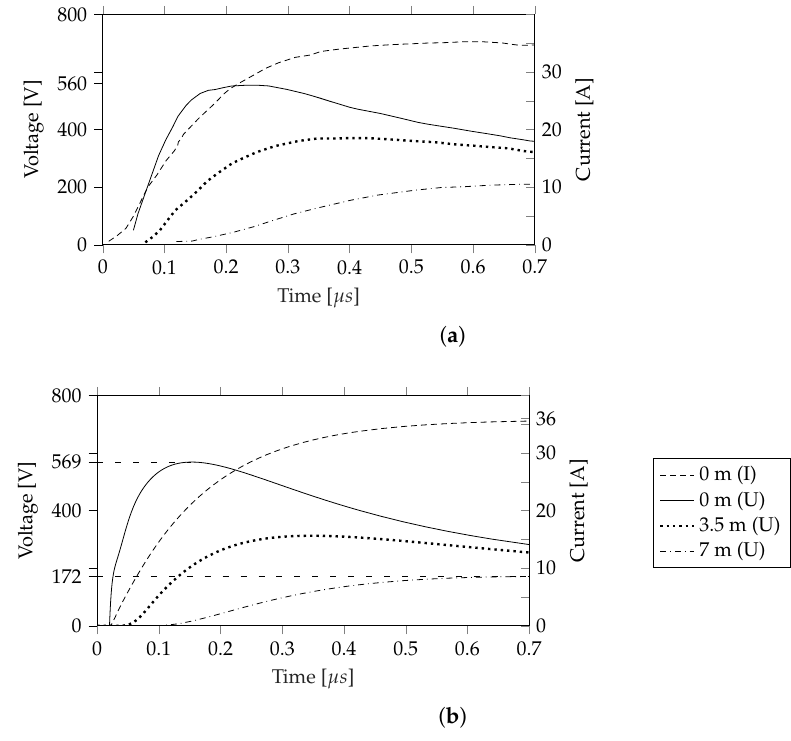
Figure 3. Voltage distribution along an horizontal copper wire in ground (length l = 15 m, conductor radius a = 0.012 m, at soil depth d = 0.6 m) in soil of ρ soil = 70 Ω m and (cid:101) r soil = 15: ( a ) the reproduced results for comparison from the research given in [11] (p. 818); and ( b ) results from implemented model with excitation current ˆ I = 36 A of double exponential waveform ( α = 32 × 10 3 , β = 7.6 × 10 6